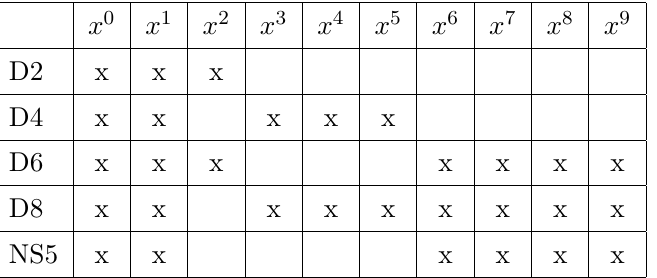
-BPS brane intersection underlying the AdS solutions (3.19)–(3.21). ( x 0 , x 1 ) are the Table 3 . 1 3 8 directions where the 2d dual CFT lives. x 2 is the field theory direction, that we identify with y , where the NS5-branes are located (for x sufficiently large). The D2 and D6-branes are stretched in this direction. ( x 3 , x 4 , x 5 ) are the directions associated to the isometries of the S 2 while ( x 6 , x 7 , x 8 , x 9 ) are those associated to the S 3